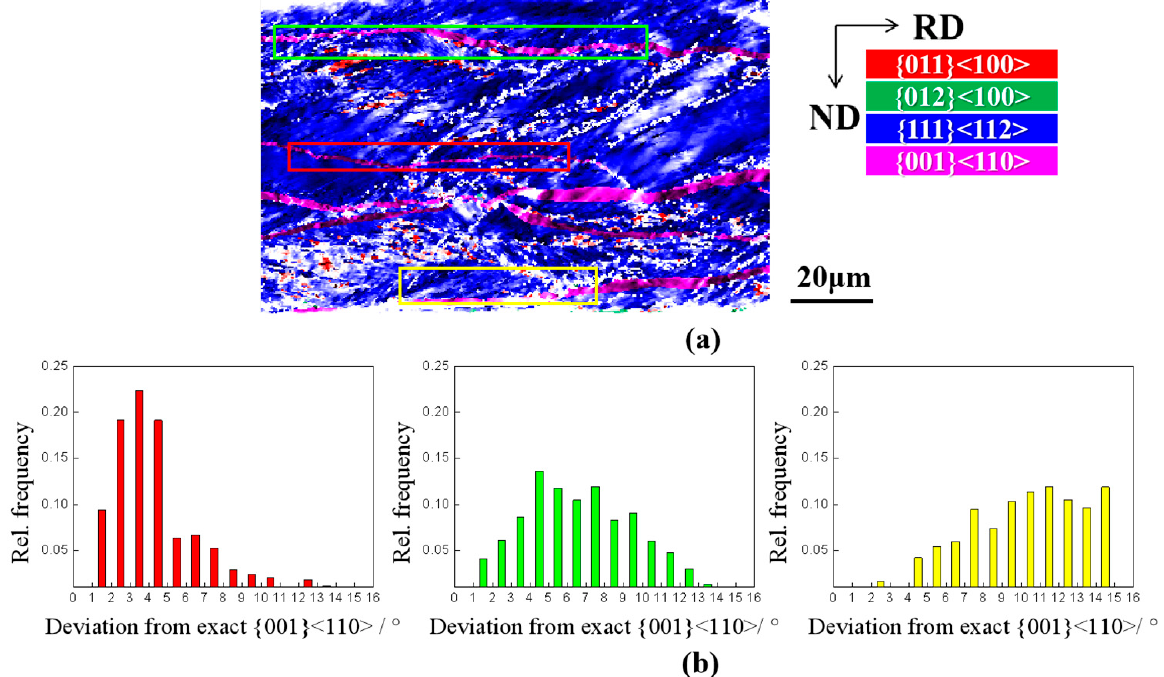
Figure 5. EBSD measurement in deformation twinning area of exact Goss orientated grains with a reduction of 78% in transverse plane with step size=0.3 μ m: (a) orientation image mapping; (b) the distribution of the deviation degree between twinning orientation and exact Goss orientation in the area marked by different color block diagram in (a).